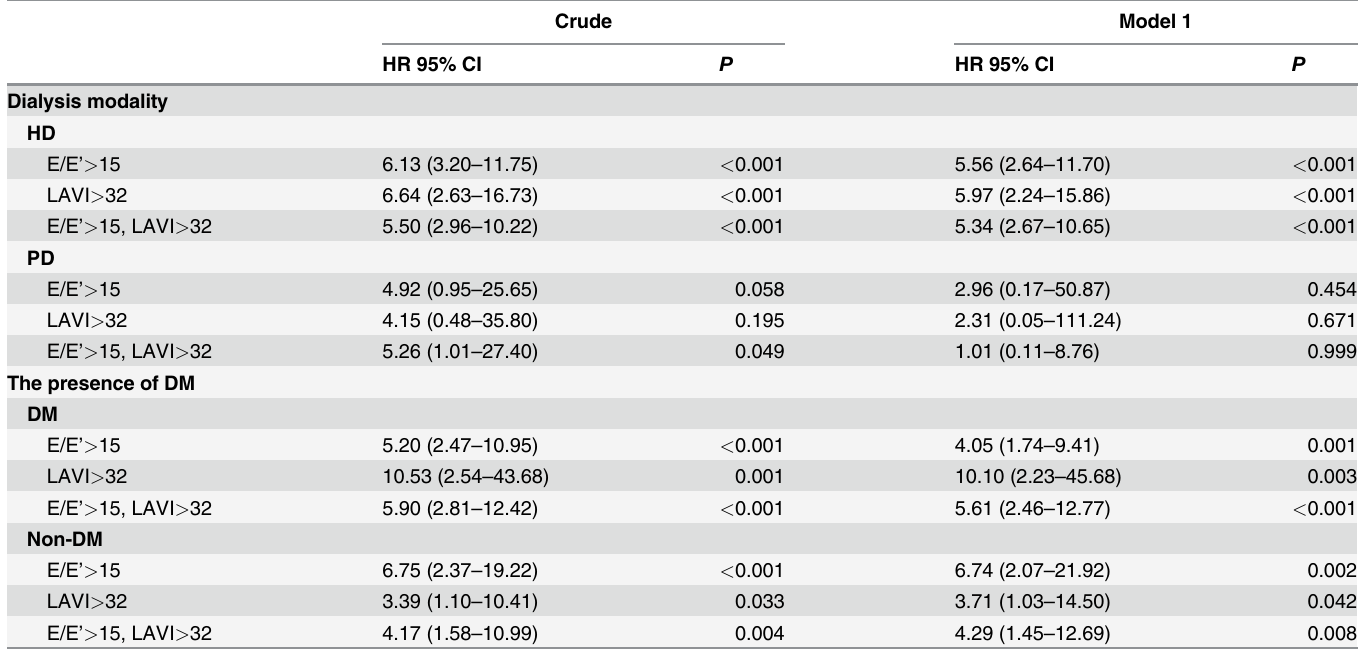
Table 8. Multivariate Cox proportional hazards regression analysis for CV events according to dialysis modality or the presence of DM. Crude Model